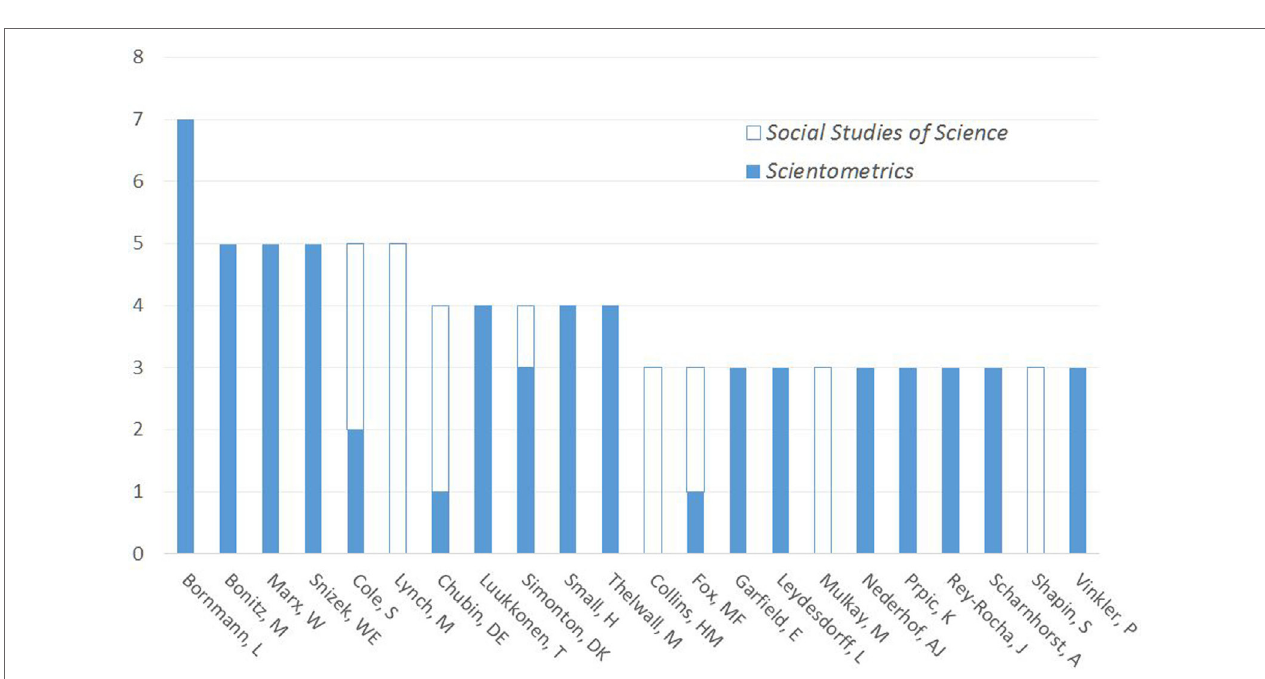
FigUre 6 | Distribution of references to Merton in papers in Scientometrics and Social Studies of Science , respectively ( n of documents = 391) .